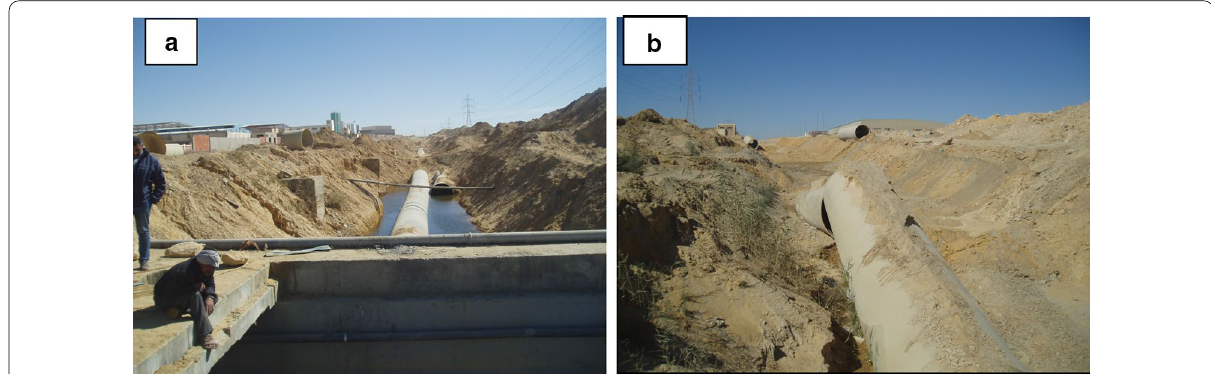
Fig. 9 Field photographs for the pipeline in Wadi Degla ( a , b ,